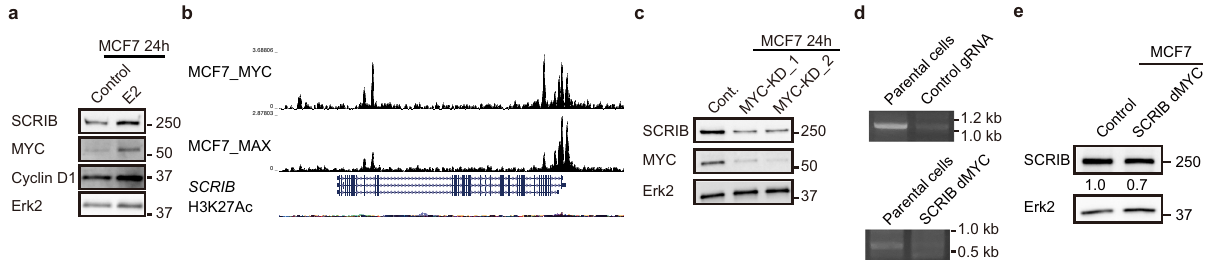
Fig. 6 SCRIB is a target of MYC. a SCRIB induction by E2 stimulation in MCF-7 cells. b ChIP-Seq analysis of MYC and MAX in MCF-7 cells. c The protein levels of SCRIB in MYC-KD MCF-7 cells. d PCR detection of genomic deletion in MCF-7 cells. e Total protein levels of SCRIB in genome-edited MCF-7 cells. is used for cysteine biosynthesis from methionine, suggesting a role for amino acid metabolisms. How the changes in metabolome promote proliferation and drug resistance will be an important and new avenue of investigation. Methods Cell lines . MCF-7 cells were cultured in MEM (Nacalai # 21443-15) supplemented with 10% heat-inactivated FBS, 1mM sodium pyruvate, and 10µg/ml insulin. T47D cells were cultured in RPMI 1640 (Nacalai #30264-85) supplemented with 10% heat-inactivated FBS and 5µg/ml insulin. AU565 cells, HCC1569 cells, and BT474 cells were cultured in RPMI 1640 (Nacalai # 30264-85) supplemented with 10% heat-inactivated FBS. HEK293T cells, MDA-MB-231 cells, and Hs578T cells COMMUNICATIONS BIOLOGY| (2022) 5:403